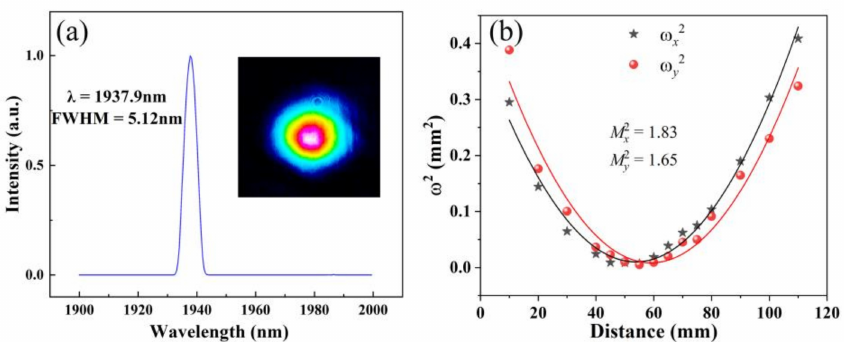
Figure 7. ( a ) The spectrum of the 2- µ m pulsed laser (the insert picture is the beam profile). ( b ) Beam quality M 2